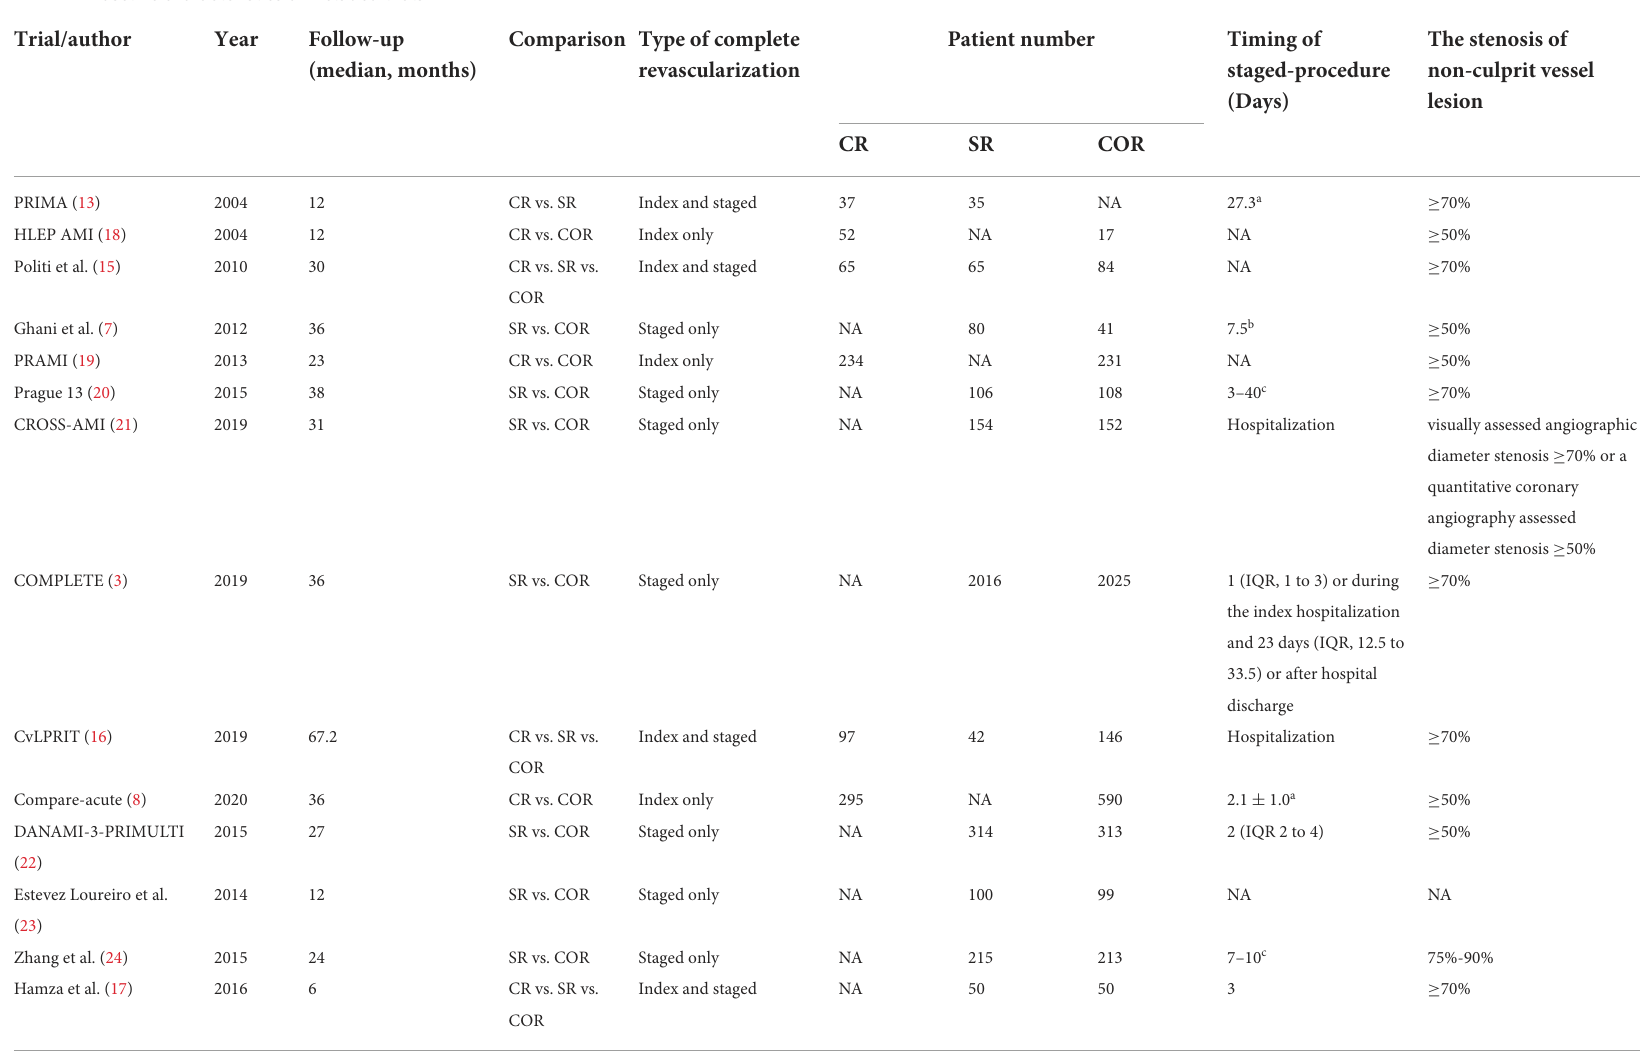
TABLE 1 Baseline characteristics of included